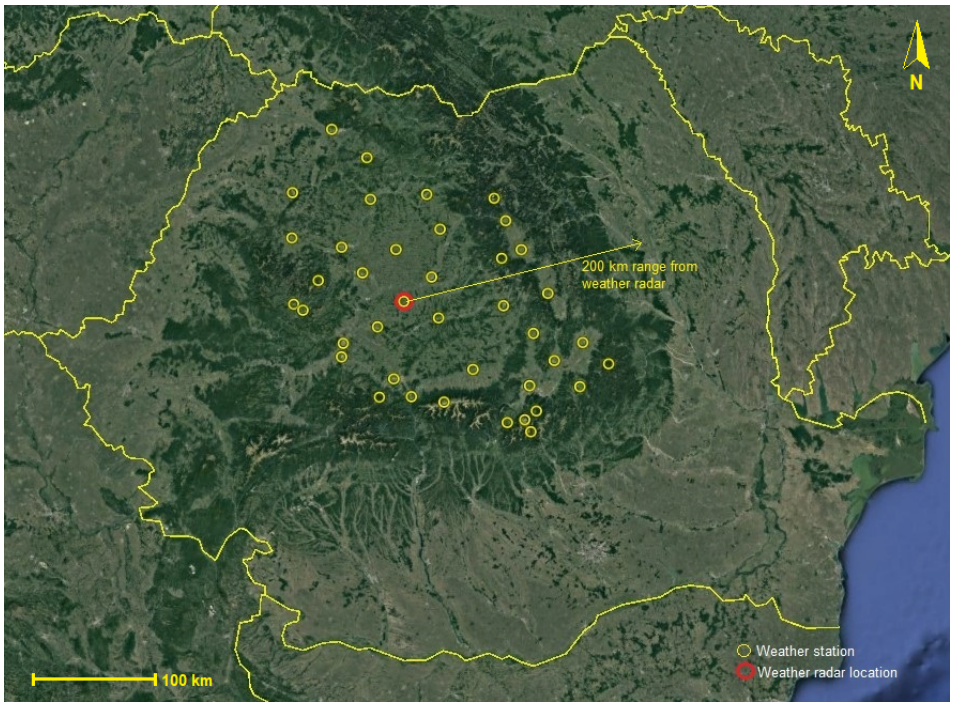
Figure 1. Locations of the 40 weather stations used in the study. Background map source: Google